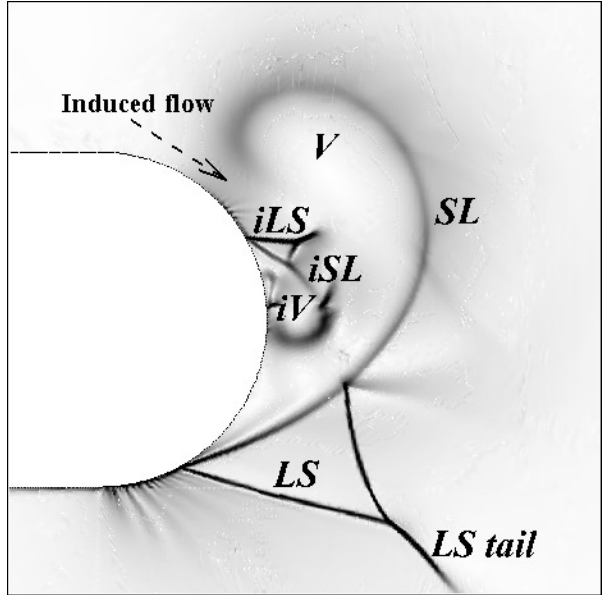
Fig. 7. Schlieren showing flow features of shock wave diffraction around curved splitter. SL : shear layer, V : vortex, LS : lambda shock, iSL : internal shear layer, iV : internal vortex, and iLS : internal lambda shock.